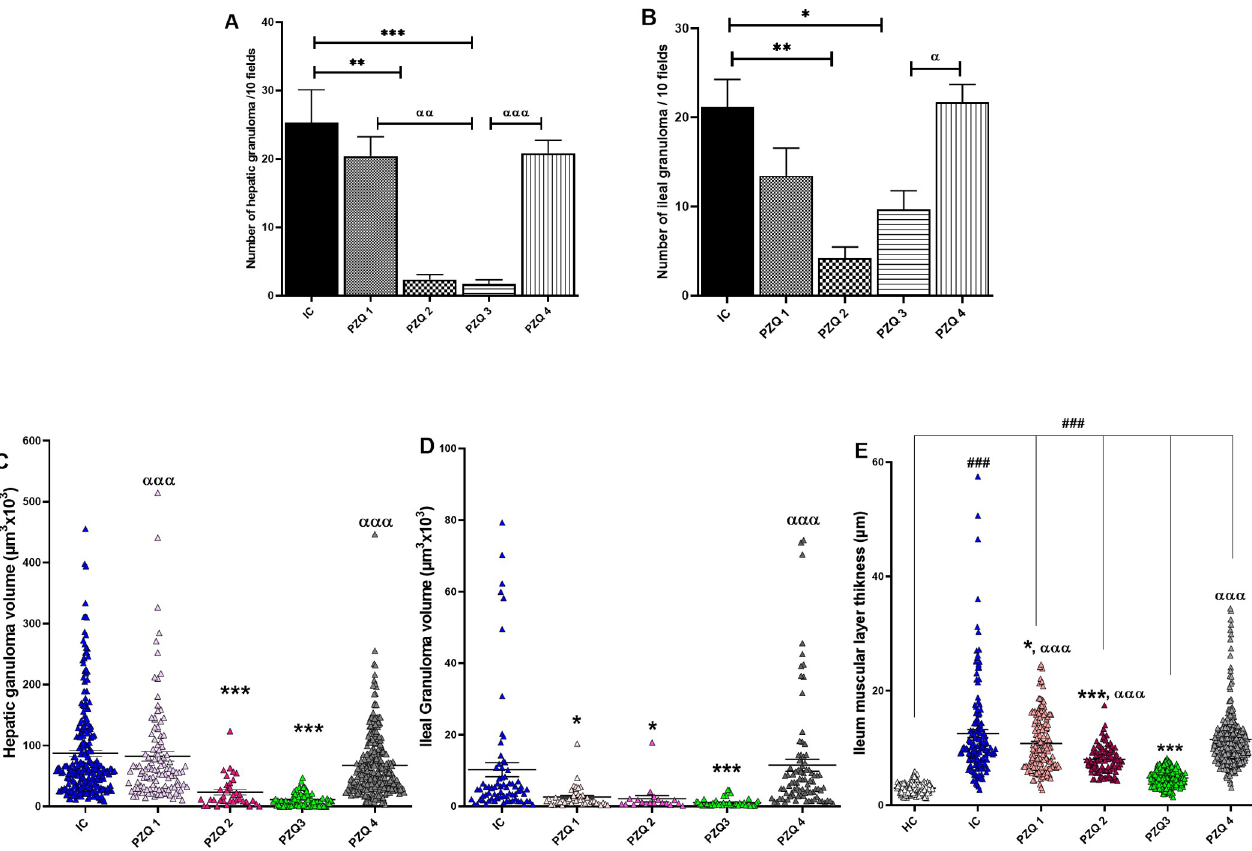
Fig 9. Effect of praziquantel treatment on the morphometry of the liver and the ileum of Schistosoma mansoni -infected mice. ( A) number of liver’s granulomas; (B) number of ileal granulomas; (C) volume of hepatic granulomas; (D) volume of ileal granulomas; (E) muscular layer thickness of the ileum. HC: Uninfected mice, IC: Infected-untreated mice, PZQ1: Infected mice treated with praziquantel at 100 mg/kg for 5 consecutive days, PZQ2: Infected mice treated with praziquantel at 100 mg/kg for 28 consecutive days, PZQ3: Infected mice treated with praziquantel at 18 mg/kg for 28 consecutive days, PZQ4: Infected mice treated with a single dose of praziquantel at 500 mg/kg. Data are expressed as mean ± SEM (n = 6). ANOVA followed by Tukey multiple comparison test was also used for statistical analysis. ### p < 0.001: values are significantly different from those uninfected mice (group HC). � p < 0.05, �� p < 0.01, ��� p < 0.001: values are significantly different from those of infected-untreated mice (group IC). α p < 0.05, αα p < 0.01, ααα p < 0.001: values are significantly different from those of infected mice treated with PZQ3 posology (group